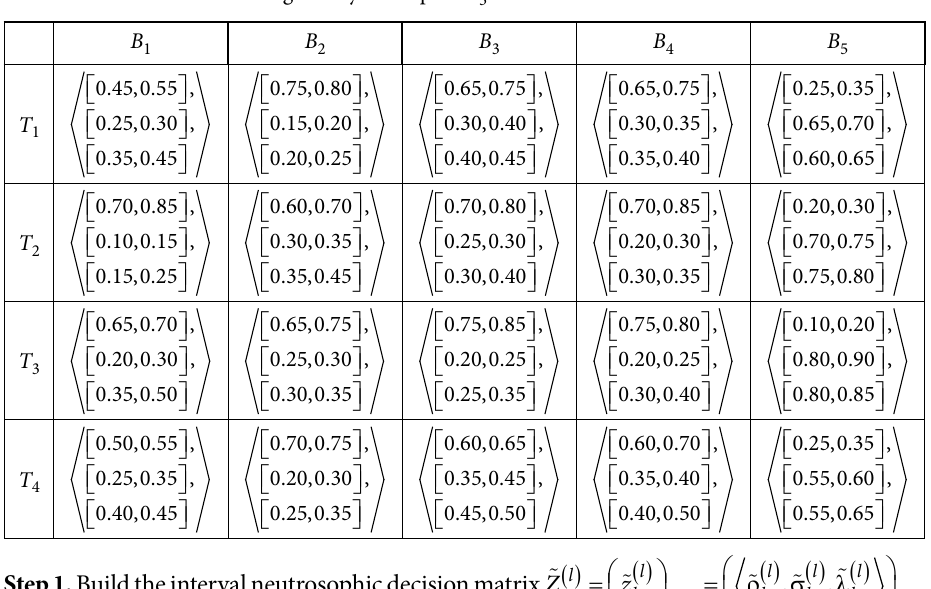
Table 3. Decision